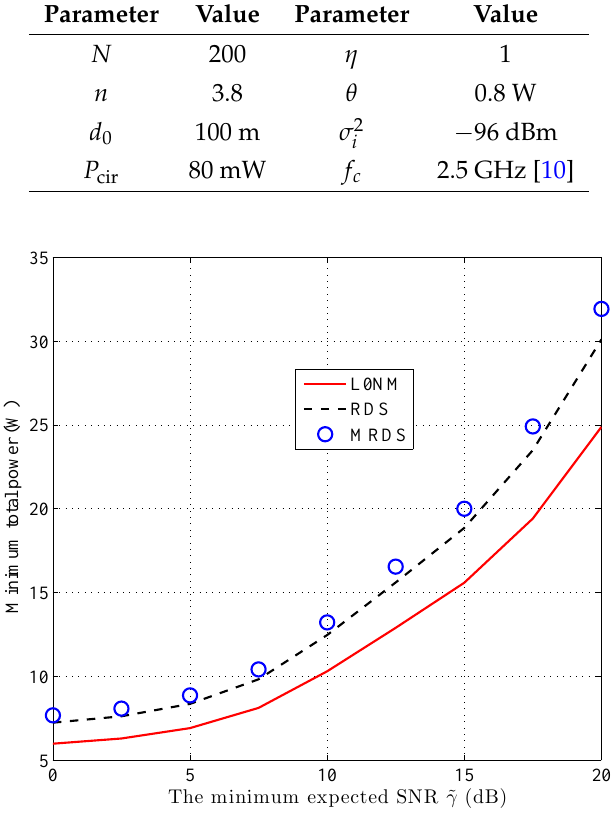
Figure 2. The average minimum total consumed power calculated by our methods versus the signal-to-noise ratio (SNR)